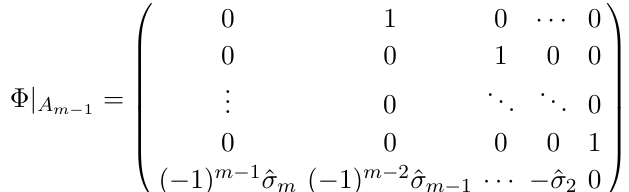
Figure 1 . Partial resolution of A 3